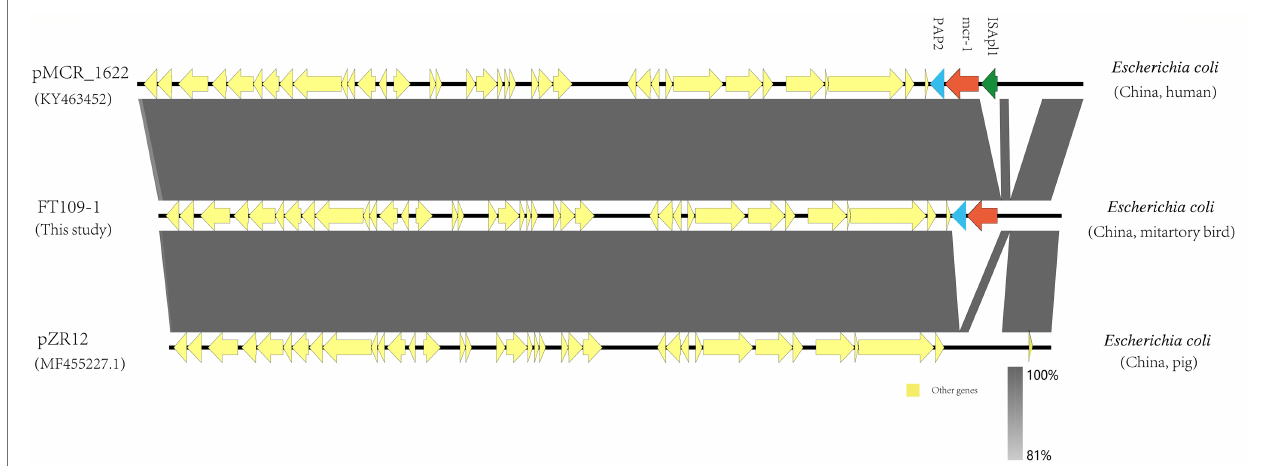
FIGURE 3 | Genomic organization between pFT109-1 and the indicated plasmids obtained from